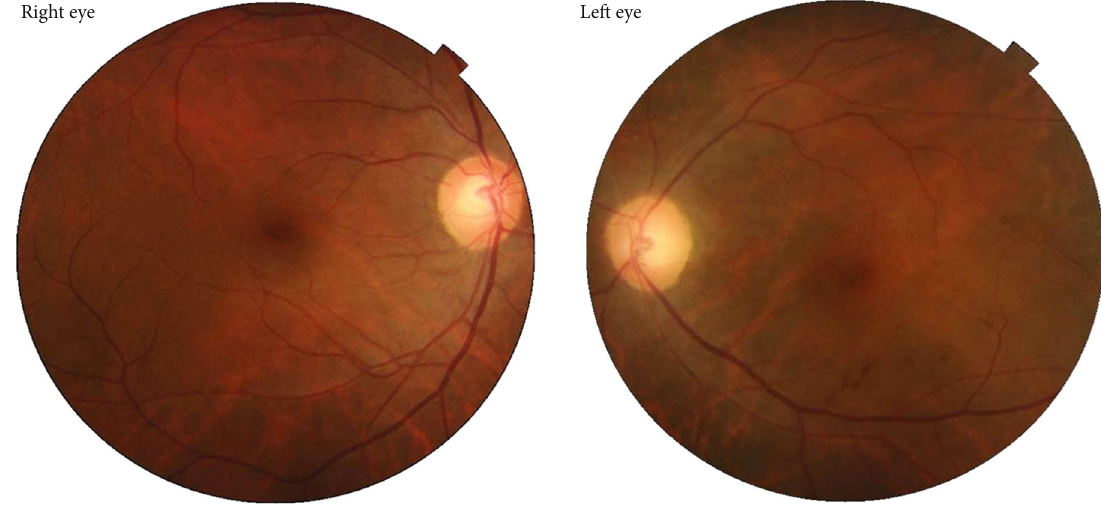
Figure 5: Fundus photo at the end of one and half-year following the injury.